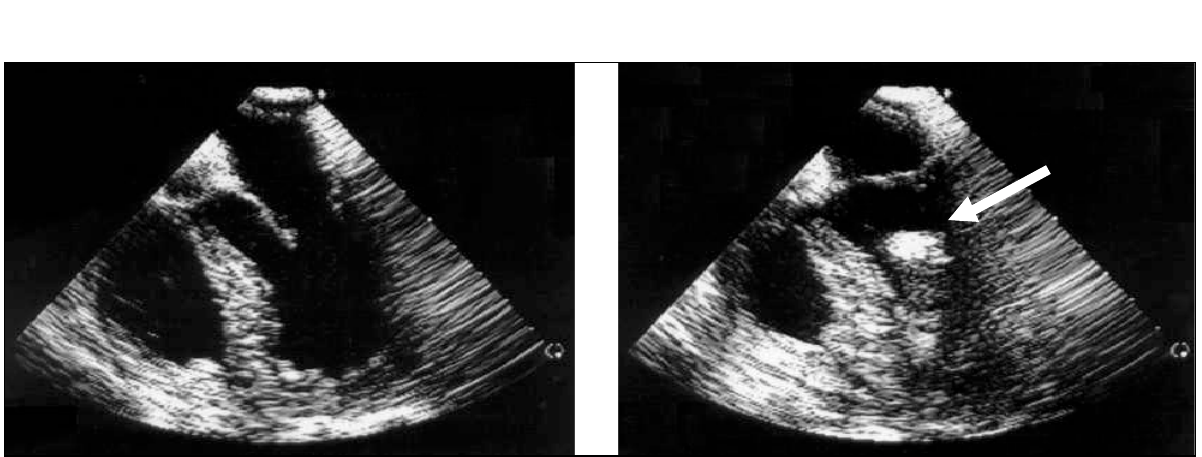
Fig. 2 - Ecocardiografia transesofágica intra-operatória no plano transverso cardíaco. Pode-se observar o efeito de microbolhas na cavidade ventricular esquerda (seta), decorrente da dissipação do calor do raio Laser ao entrar em contato com o sangue. Essa imagem comprova a criação do canal